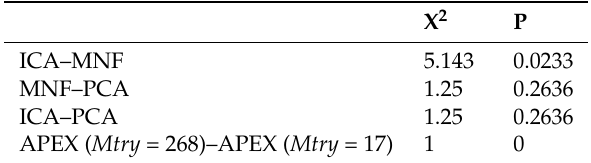
Table 3. Evaluation of classification methods according to McNemar’s test.